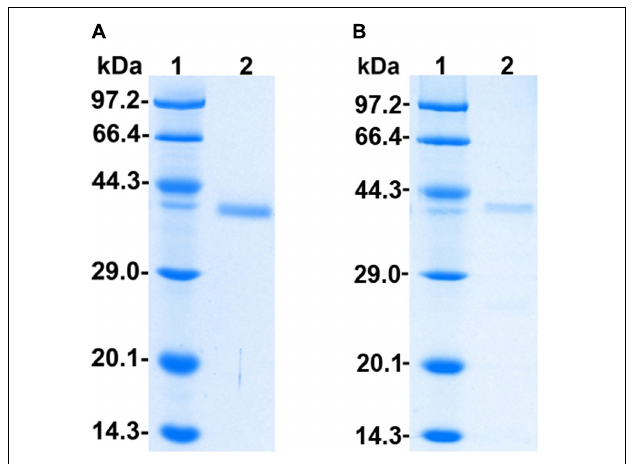
FIGURE 1 | SDS-PAGE analysis of PoxaEnPG28B-Pp and PoxaEnPG28B-Ec. Lane 1 (A,B) protein molecular weight ladder (3450Q, from Takara, Co., Ltd., Dalian, China); lane 2, The purified recombinant proteins PoxaEnPG28B-Pp (A) and PoxaEnPG28B-Ec (B)